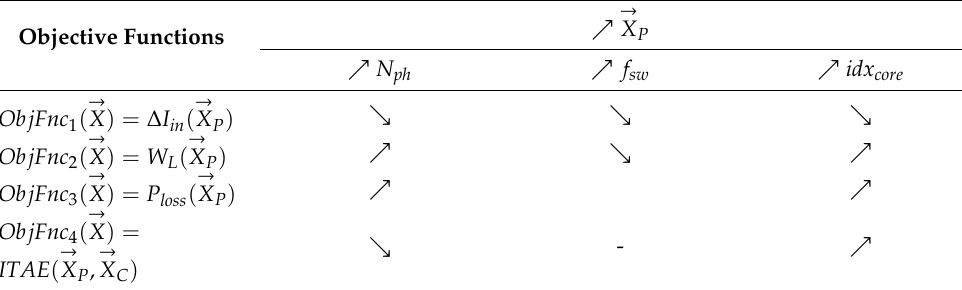
Table 4. Impact of design variables on objective